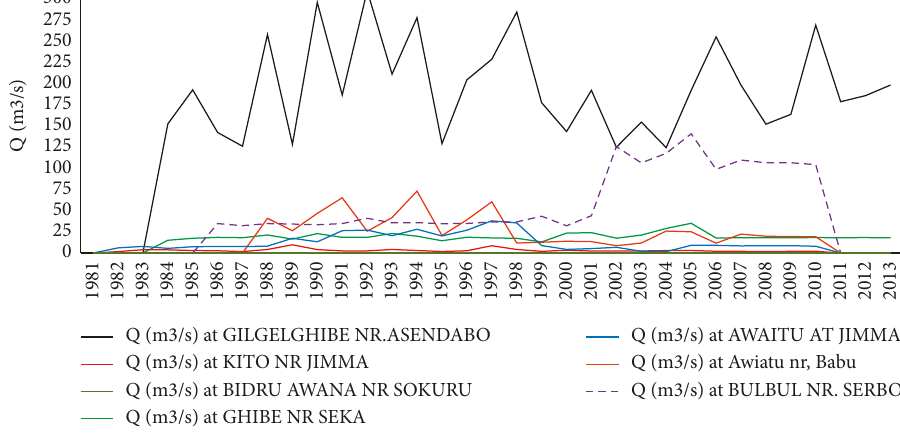
Figure 6: Time series for stream